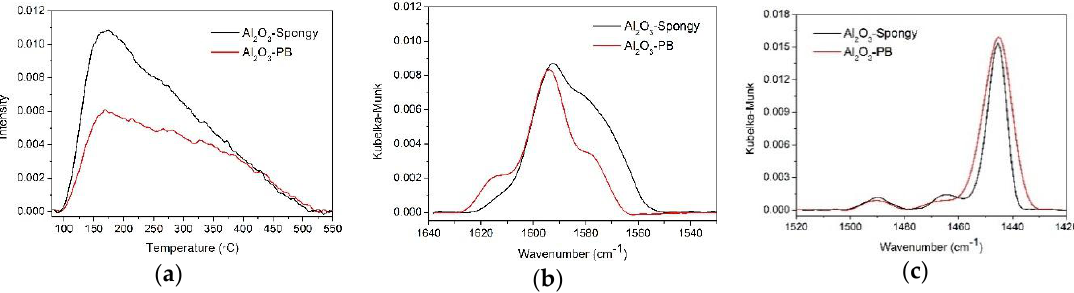
Figure 4. ( a ) NH 3 -TPD profiles obtained from Al 2 O 3 -Spongy and Al 2 O 3 -PB, and ( b , c ) DRIFT spectra of pyridine adsorption on the obtained alumina samples.